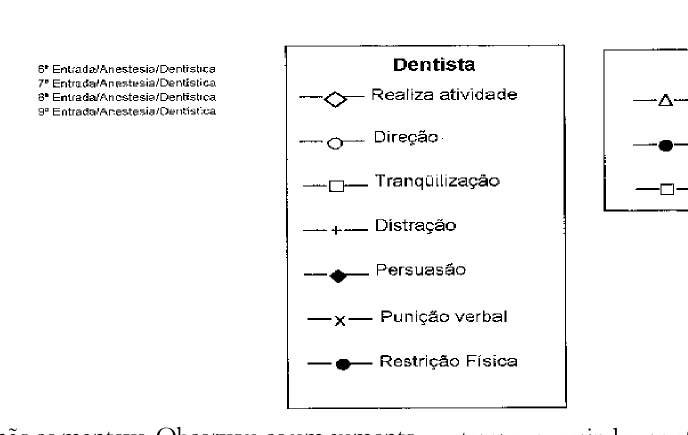
comportamental nªo se manteve. Observou-se um aumento da freq(cid:252)Œncia acumulada da categoria (cid:147)colabora(cid:231)ªo sem restri(cid:231)ªo f(cid:237)sica(cid:148) na oitava e nona sessıes. Discussªo